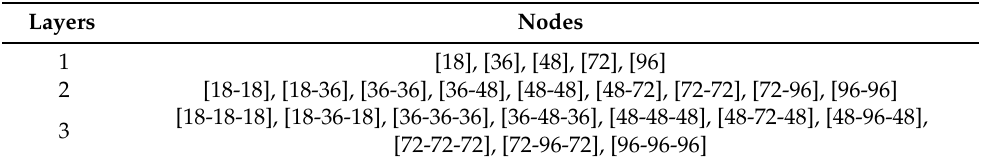
Table 2. Combination of layers and neurons adopted for the proposed investigation for the four neural networks